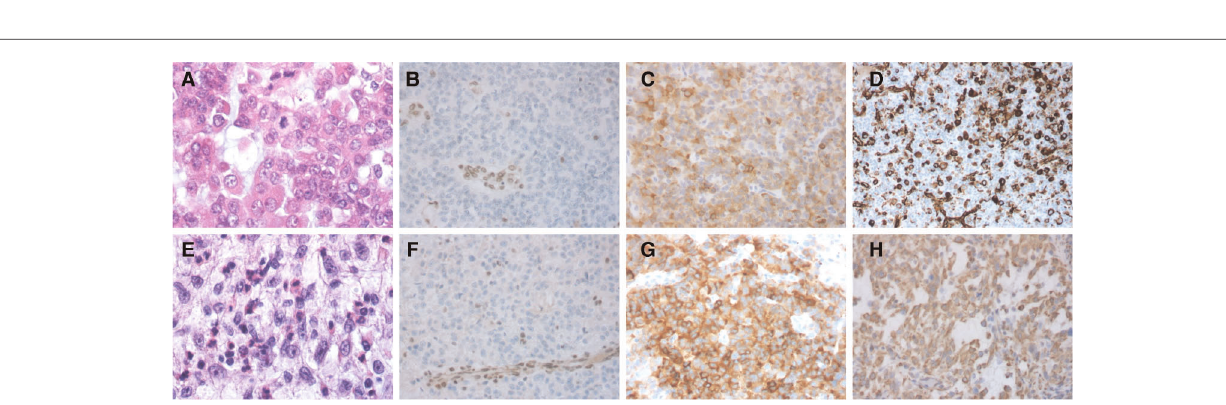
FIGURE 3 | Hematoxylin and eosin stain (H&E) and immunohistochemical features of the cases. Case 1: ( A ) The majority of the tumor cells displayed eccentric round nuclei and prominent nucleolus; ( B ) IHC showing the tumor is negative for integrase interactor 1 (INI1), with vascular endothelial cell internal control being positive; ( C ) positive for Synaptophysin; and ( D ) partially positive for vimentin. Case 2: ( E ) Brisk mitotic activity is common; ( F ) Immunostaining showed a lack of INI1 protein expression in the tumor cells and apoptotic bodies; ( G ) positive for Synaptophysin; and ( H ) partially positive for